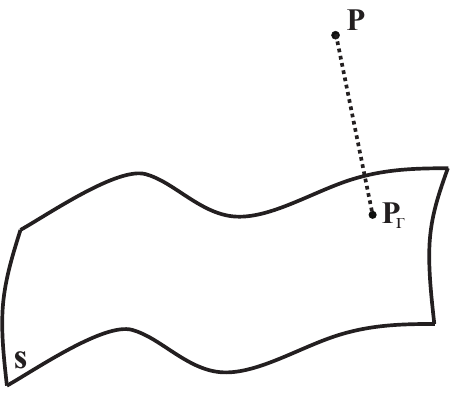
Figure 1. Point orthogonal projection onto an algebraic